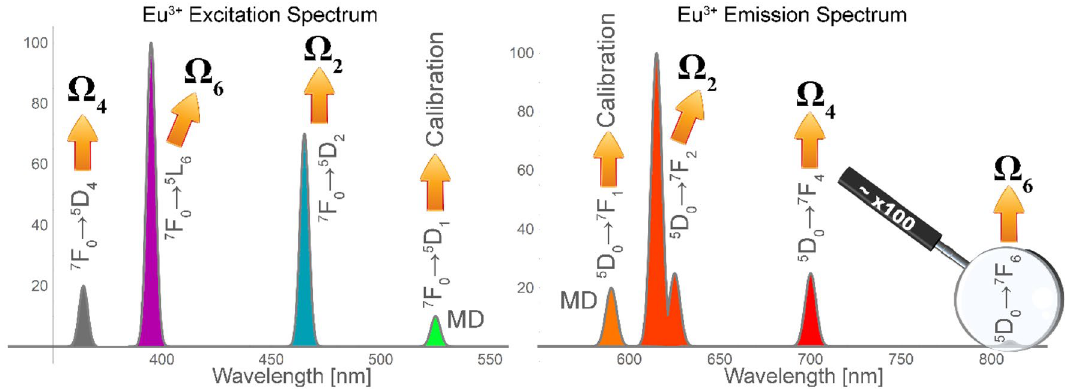
Figure 2. JO parametrisation schemes using the excitation and emission spectra of the Eu 3+ ion: JOEX (left) and Krupke’s method (right).